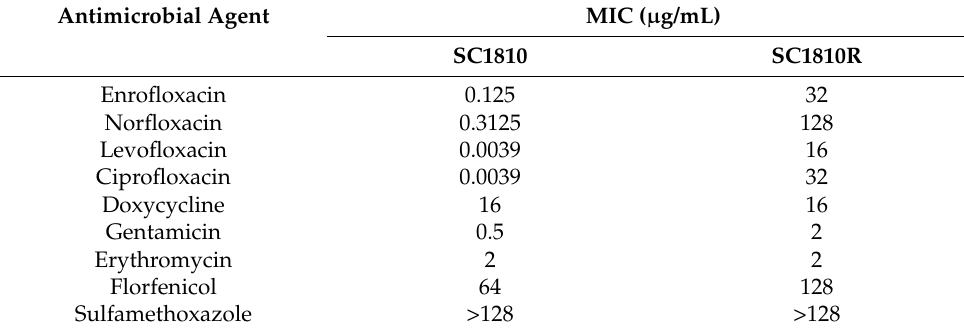
Table 1. Susceptibility of A. pleuropneumoniae strains to different antimicrobials. Antimicrobial Agent